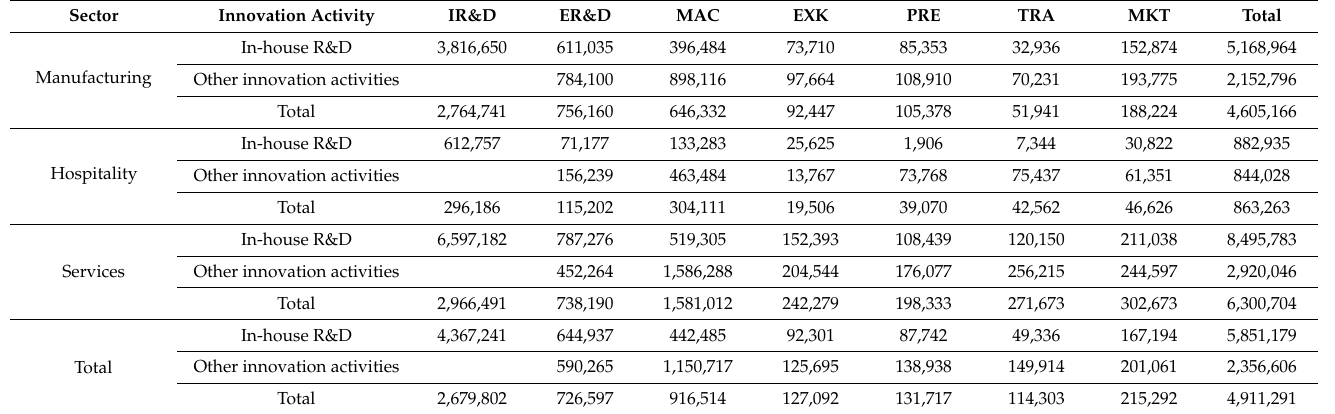
Table 9. Expense in innovation activities by industry ( €